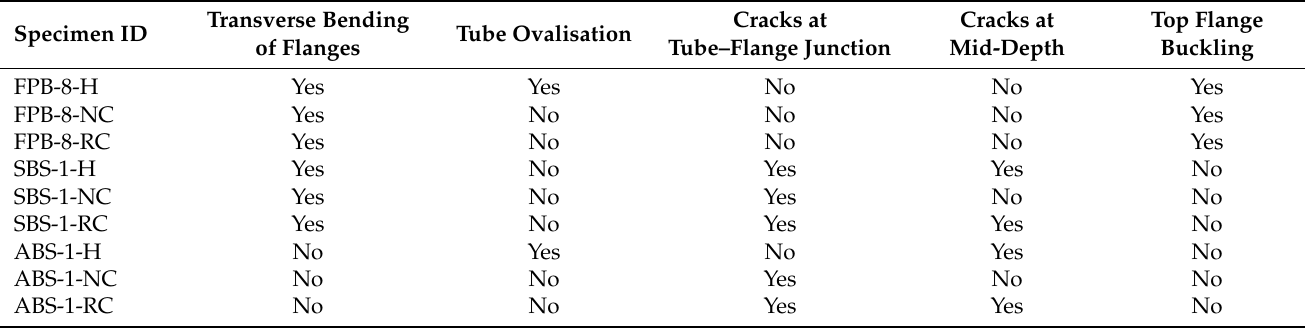
Table 3. Summary of the failure for different